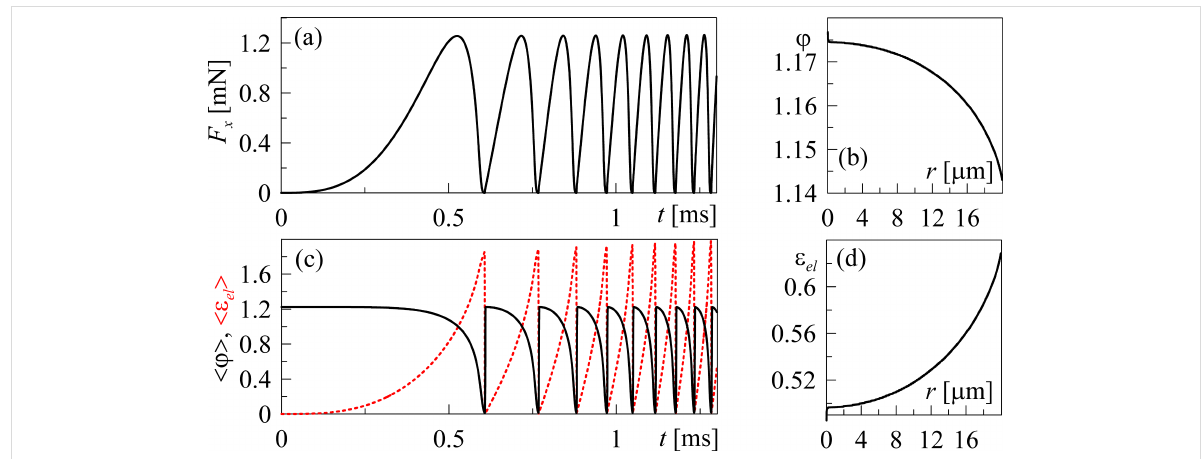
Figure 2: (a) Kinetic dependence of the friction force F x ( t ), calculated at parameters τ max = 10 6 Pa, = 1.0, a = 10 6 Pa, h 0 = 10 − 7 m, γ = 10 (Pa·s) − 1 , a 0 = 2·10 − 5 m, G * = 10 9 Pa, K = 500 N/m, m = 0.1 kg, V 0 = 1 m/s. (b) Spatial distribution of the order parameter φ ( r ) in the moment of time t = 1.3 ms, related to final point of the dependence shown in Figure 2a. (c) Time dependence of the mean values of the order parameter < φ > (solid line) and elastic strain < ε el > (dashed line). (d) Spatial distribution of the elastic strain ε el ( r ) at t = 1.3